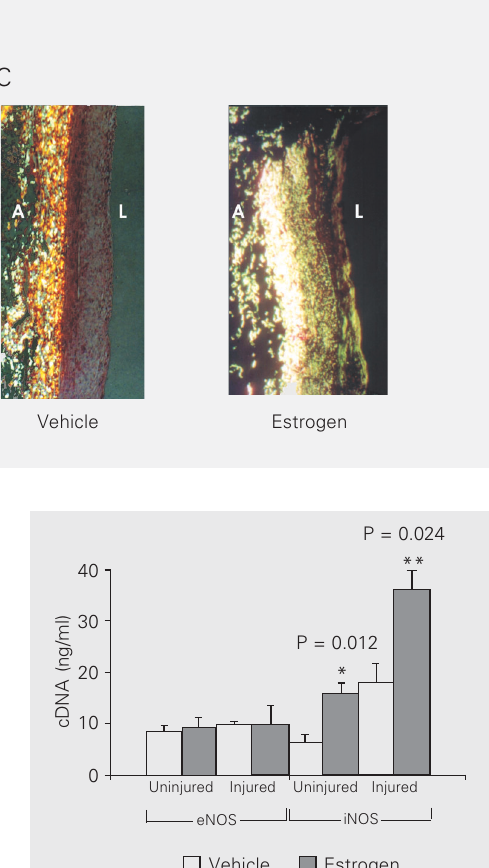
Figure 1. Panel A , Bar graph de- picting % change in in vivo iliac artery lumen caliber in vehicle- or estrogen-treated rabbits, N = 6 for each group; *P < 0.001 vs control ( t -test). Panel B , Abso- lute values of arteriographic cali- ber at baseline and 14 days af- ter injury in vehicle- or estrogen- treated rabbits; *P = 0.009 vs pre-injury (Student paired t -test). Panel C , Representative Picro- syrius staining of the iliac artery 14 days after injury in vehicle- or estrogen-treated rabbits viewed under the polarized light micro- scope. A = adventitia; L = lu-